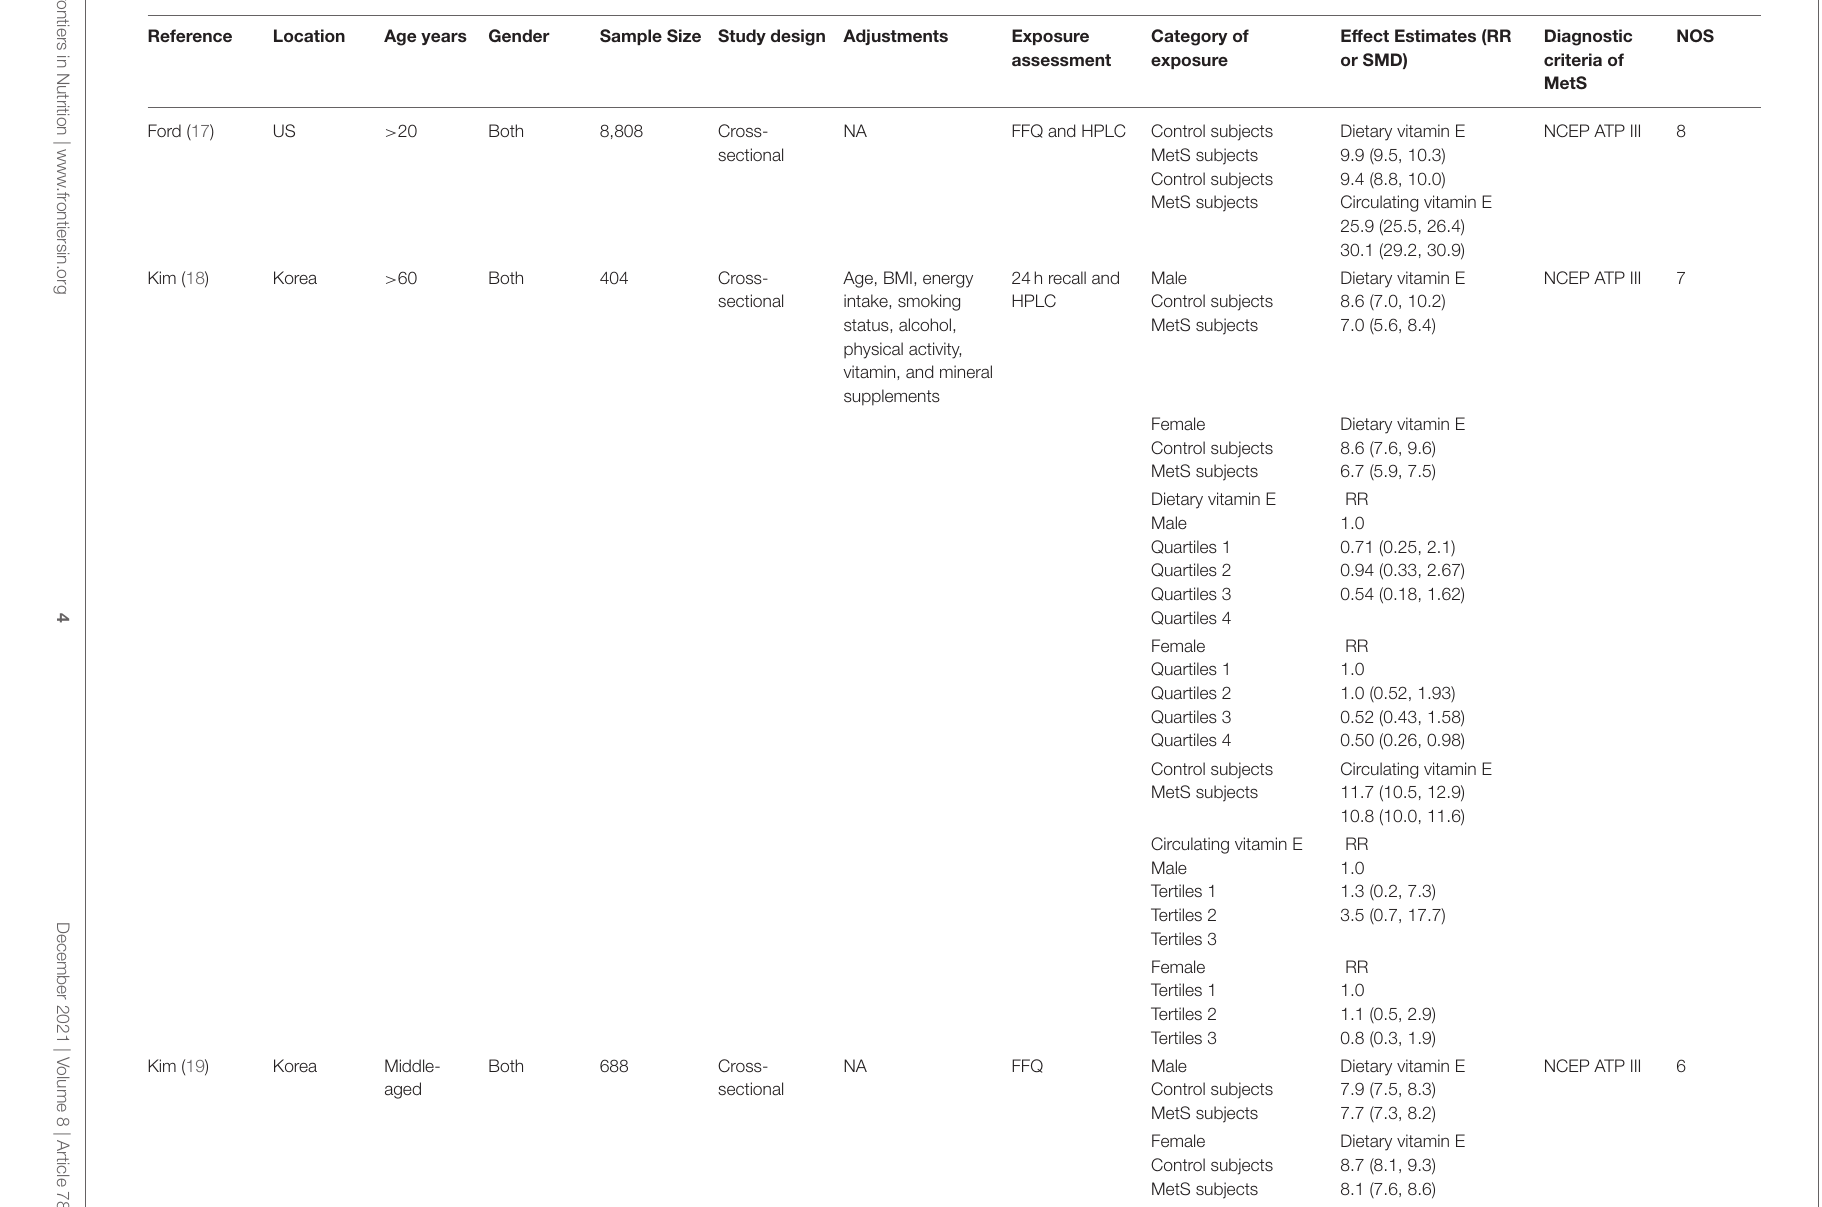
TABLE 1 | Characteristics of the individual studies included in this